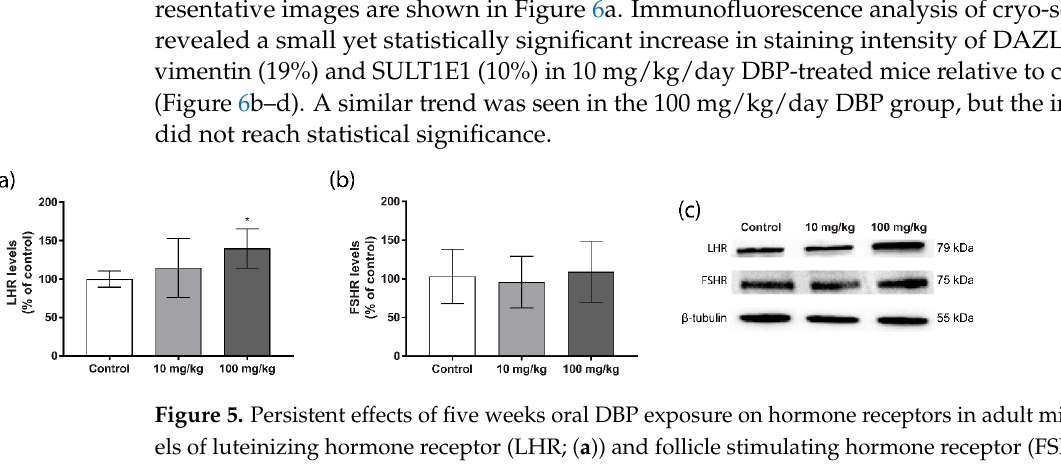
Figure 5. Persistent effects of five weeks oral DBP exposure on hormone receptors in adult mice. Levels of luteinizing hormone receptor (LHR; ( a )) and follicle stimulating hormone receptor (FSHR; ( b )) were measured by Western blot in mouse testis collected one week after the last DBP administration. Values represent mean ± S.D. from 12 animals per group. Representative blots of three experiments are shown ( c ). β -tubulin was used as a loading control. Statistically significant differences from control are indicated as follows: * p < 0.05 (One-way ANOVA followed by Dunnet’s test).